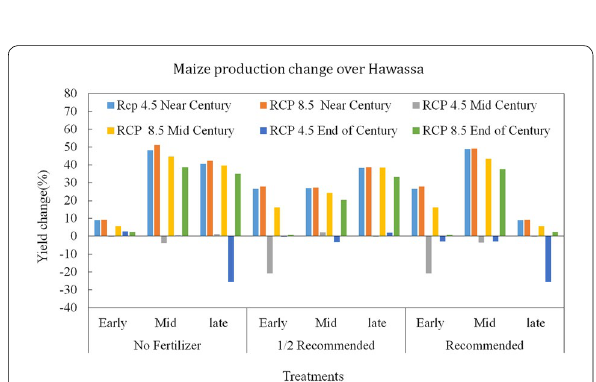
Fig. 7 The simulated maize yield in relation to future climate sce- narios at